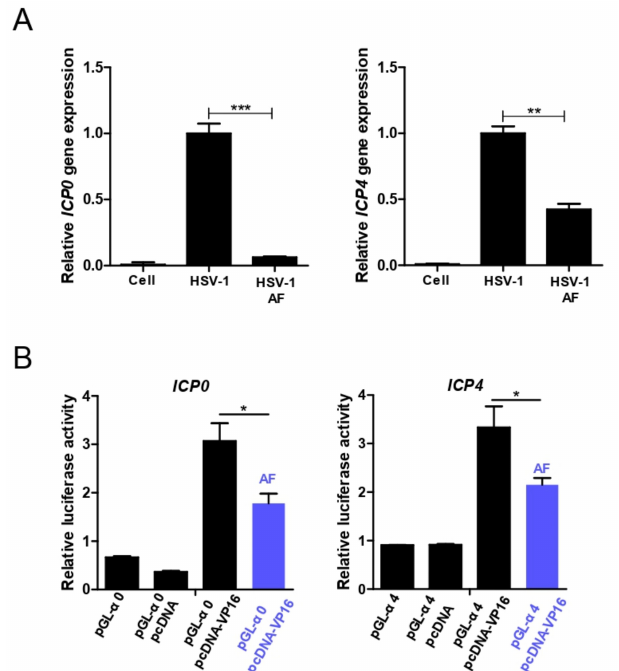
Figure 8. Amentoflavone inhibits the promoter activity of viral immediate early gene. ( A ) Vero cells were infected with HSV-1 (MOI = 1) in the presence of amentoflavone (50 µ M) or DMSO for 3 h and the expression of ICP0 and ICP4 was detected by qRT-PCR, respectively. Data are mean ± SD ( n = 3). ** p < 0.01; *** p < 0.001. ( B ) Vero cells seeded in 48-well plates were transfected with indicated plasmid combinations for 24 h, the cell lysates were then subjected to luciferase activity assays. The cells only transfected with pGL- α 0 plasmids (pGL- α 4 plasmids) or cotransfected with pGL- α 0 and pcDNA plasmids (pGL- α 4 and pcDNA plasmids) were treated as the negative control. Data are mean ± SD ( n = 3). * p <